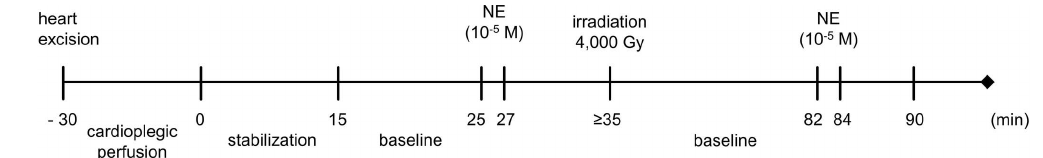
Figure 2 Experimental protocol of the heart preparation in the Langendorff setup at the IMBL beamline. After a short cardioplegic phase, the hearts were supplied with oxygenated perfusion solution. The hearts were stimulated with NE (10 (cid:2) 5 M ) once before and once after the irradiation to determine the cardiac